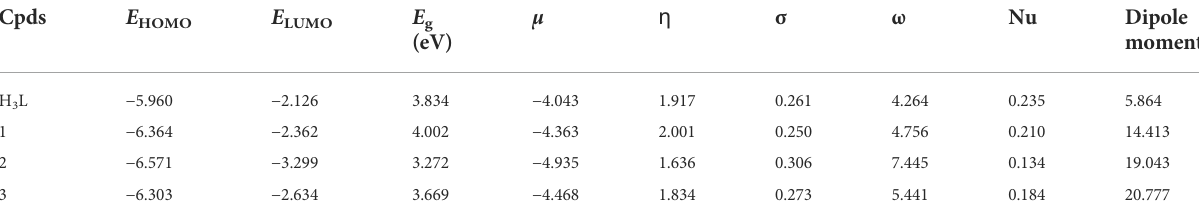
TABLE 6 Quantum chemical descriptors of the ligand and its metal